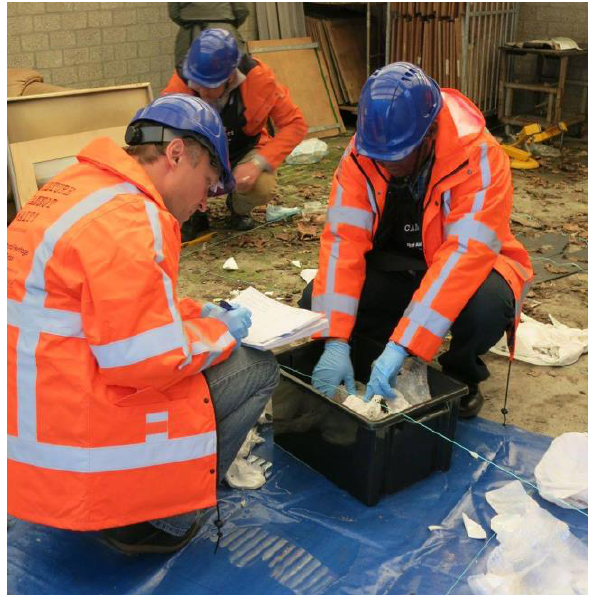
Figure 2. Rapid documentation and inventory exercise